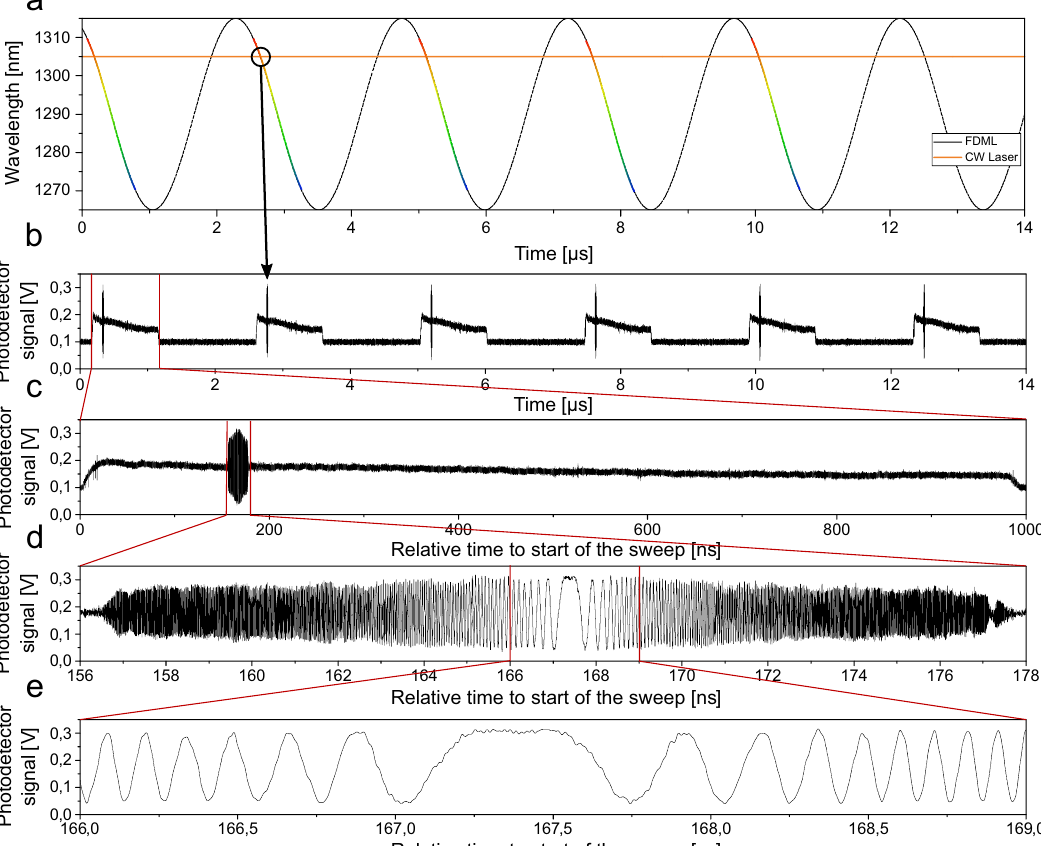
Fig. 2 Swept phase continuity measurements to determine the chirped phase characteristics of Fourier domain mode-locked laser. The Fourier domain mode-locked (FDML) sweep can be idealized by a sinusoidal sweep in wavelength ( a ). The continuous wave (CW) laser is a monochromatic laser, represented here by a constant wavelength over time. Thus, around the intersection points, a beat note signal can be measured by a fast oscilloscope. The experimental data of this beat note signal is shown in ( b ). Due to the repetitive behaviour of the swept source FDML, this beat signal occurs periodically with the roundtrip frequency. c Zoom into one FDML sweep where the beat signal occurs over an optical bandwidth of 0.7 nm (±0.35 nm). This is limited by the electronic detection bandwidth of 63 GHz (see methods). d Zoom into the beat signal reveals the chirped signal with the zero frequency point at approximately 167.4 ns. e Zoom into the middle of the beat signal. The beat signals provide an insight into the swept phase continuity of the FDML